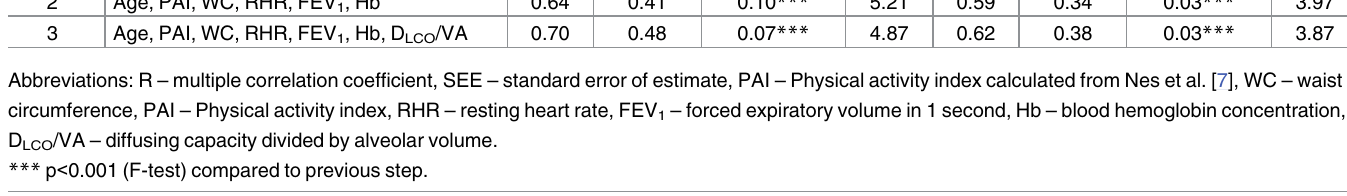
Difference between predicted and measured VO is plotted against the average of the 2peak predicted and measured VO . A line of best fit is plotted to show trends. Slope and 95% 2peak confidence interval for slope for this line is given. Shaded areas represent 95% limits of agreement.